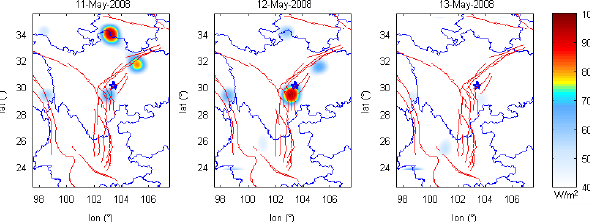
Fig. 5. The daily SLHF anomaly evolution for the Wenchuan M s = 8.0 earthquake (epicenter is marked with star, active faults with red